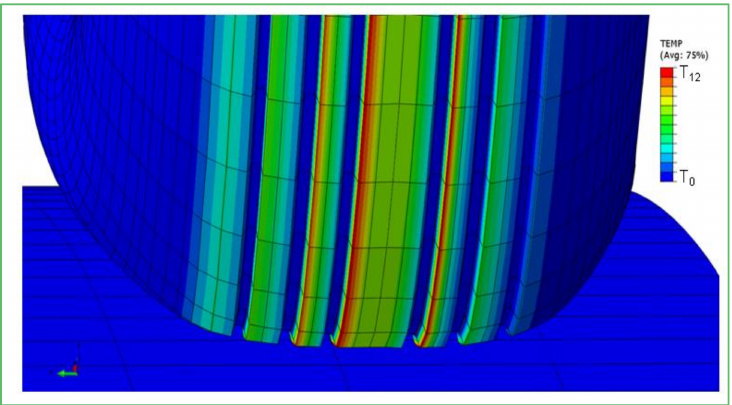
Figure 19. Numerical simulation, thermal evolution of the tire tread, numerical simulation, for a tire loading with 200 kN, rolling velocity up to 114 km/h, skidding angle of 6 ◦